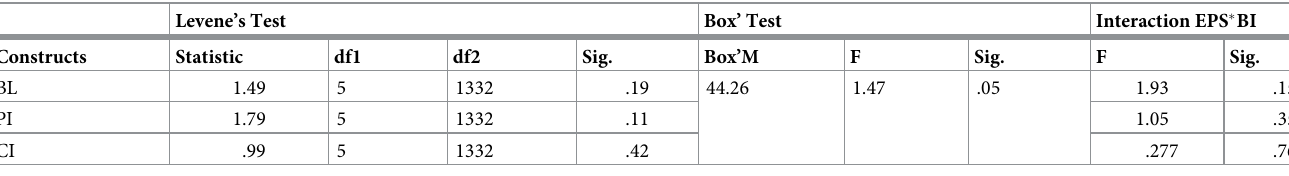
Table 10. Distribution test